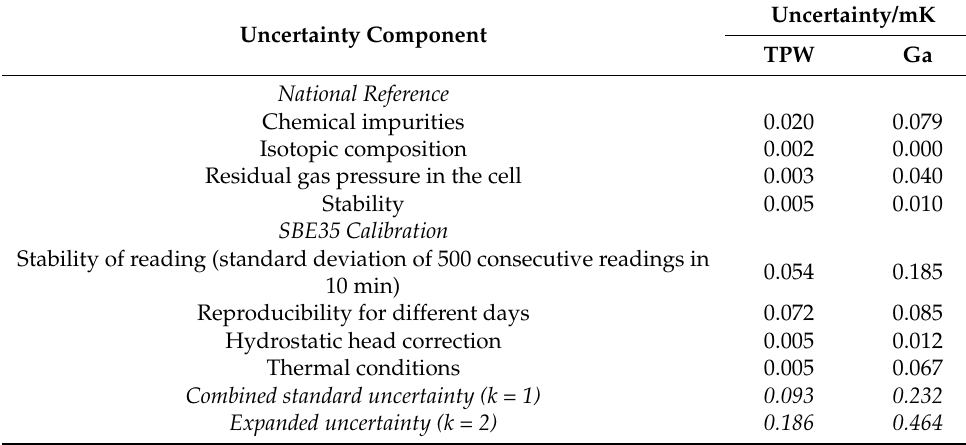
Table 1. Uncertainty budget for the recalibration of the four SBE35 units at the TPW and at the Ga.